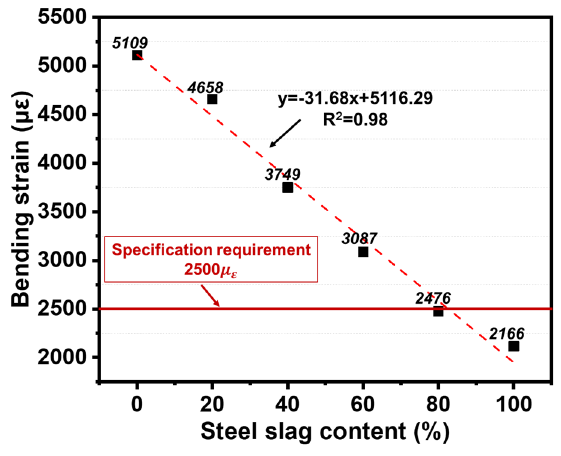
Figure 7. Low temperature performance of different steel slag contents.